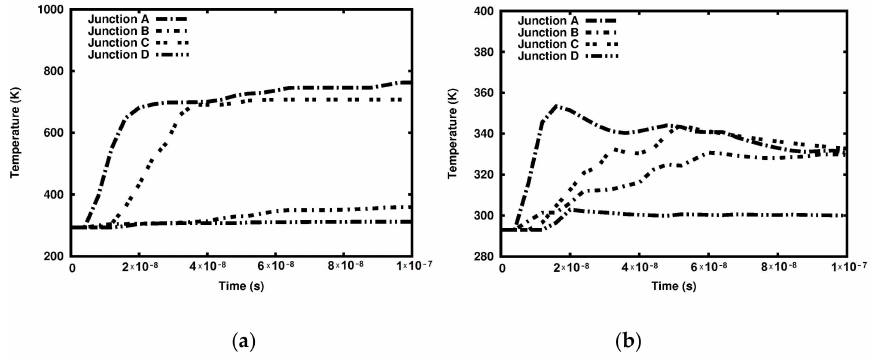
Figure 16. Temperature (K) variations at the junctions: ( a ) Adiabatic solution; ( b ) coupled